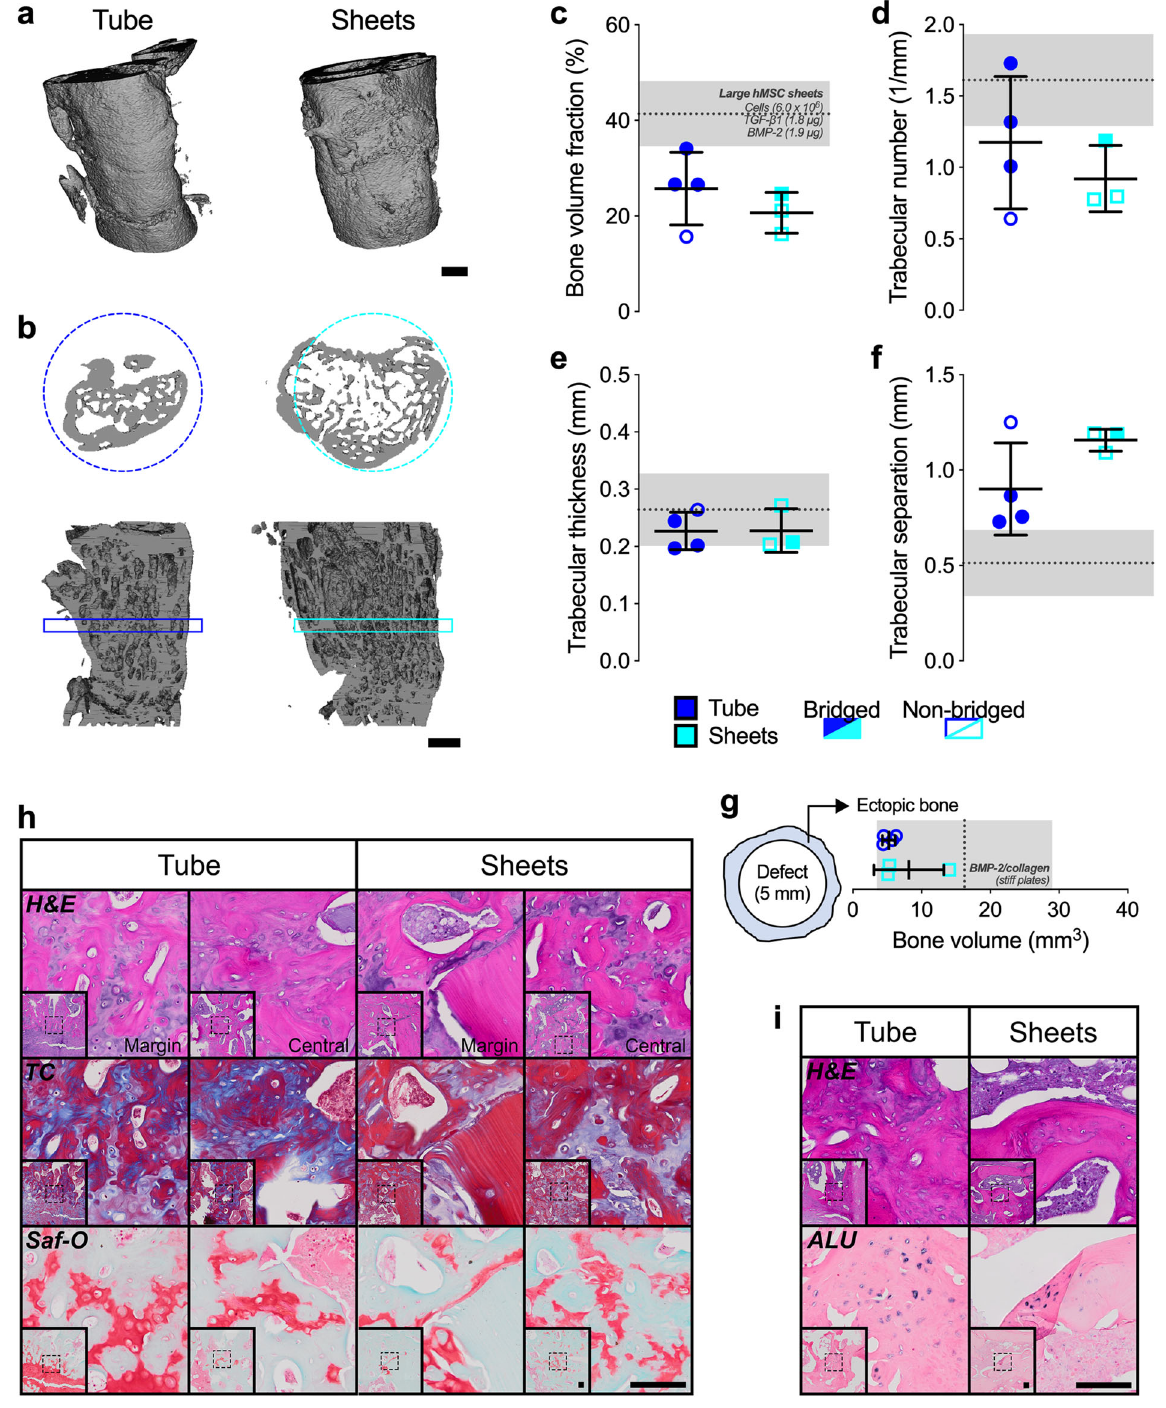
Fig. 7 Ex vivo microCT and histological evaluation of femoral defect healing induced by engineered hMSC condensate tubes and sheets. a Representative 3-D microCT defect reconstructions, implanted with hMSC tubes or sheets containing TGF- β 1 + BMP-2-loaded microparticles, with b mid-shaft transaxial (top) and sagittal (bottom) sections at week 12, selected based on mean bone volume. Scale bars, 2 mm. Morphometric analysis of c bone volume fraction, d trabecular number, e trabecular thickness, f trabecular separation, and g ectopic bone volume (i.e., bone extending beyond the 5- mm defect diameter) ( n = 4 (tubes) or 3 (sheets) biologically independent samples per group; blue circles = hMSC tubes; cyan squares = hMSC sheets; open symbols = non-bridged; closed symbols = bridged) shown with reference data from large hMSC sheets containing TGF- β 1 + BMP-2-loaded microparticles in c – f (from ref. 33 ), or BMP-2 soaked on collagen in g (from ref. 33 ). h Representative histological Hematoxylin & Eosin (H&E), Masson ’ s Trichrome (TC), and Safranin-O/Fast-green (Saf-O) staining of sagittal defect explant sections showing the defect margin and central defect; images oriented distal-to-proximal from bottom-to-top. i Representative H&E staining and in situ hybridization for human Alu repeats of sagittal defect explant sections. Scale bars, 100 μ m (dotted squares in insets show region of interest in high magni fi cation image). Individual data points are shown with mean ± SD. Analyzed by unpaired Student ’ s t -test ( p < 0.05 or lower considered signi fi